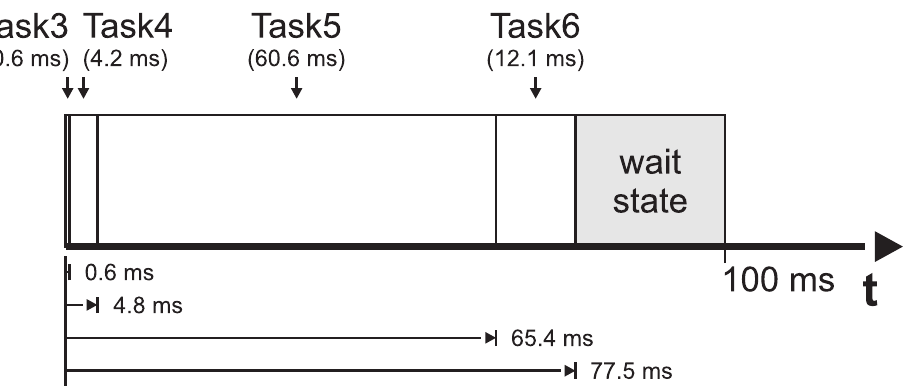
Figure 8. Computing times for the cycled tasks of the MRS; see Figure